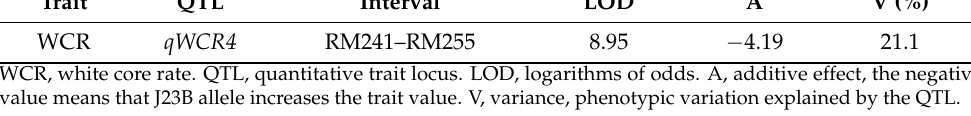
Figure 1. Genetic validation of QTL effects of qWCR7 in BC 5 F 2 population. ( a ) Chalkiness perfor- mance of NIL(BL130) (left) and NIL(J23B) (right). ( b ) SEM analysis of nonchalky (left) and chalky (lower right) grains of NIL(BL130) and NIL(J23B). ( c ) WCR difference analysis among three genotypes. ( d ) Distribution of WCR performance variation. Table 1. Genetic effect of qWCR4 in BC 5 F 2 population. Trait QTL Interval